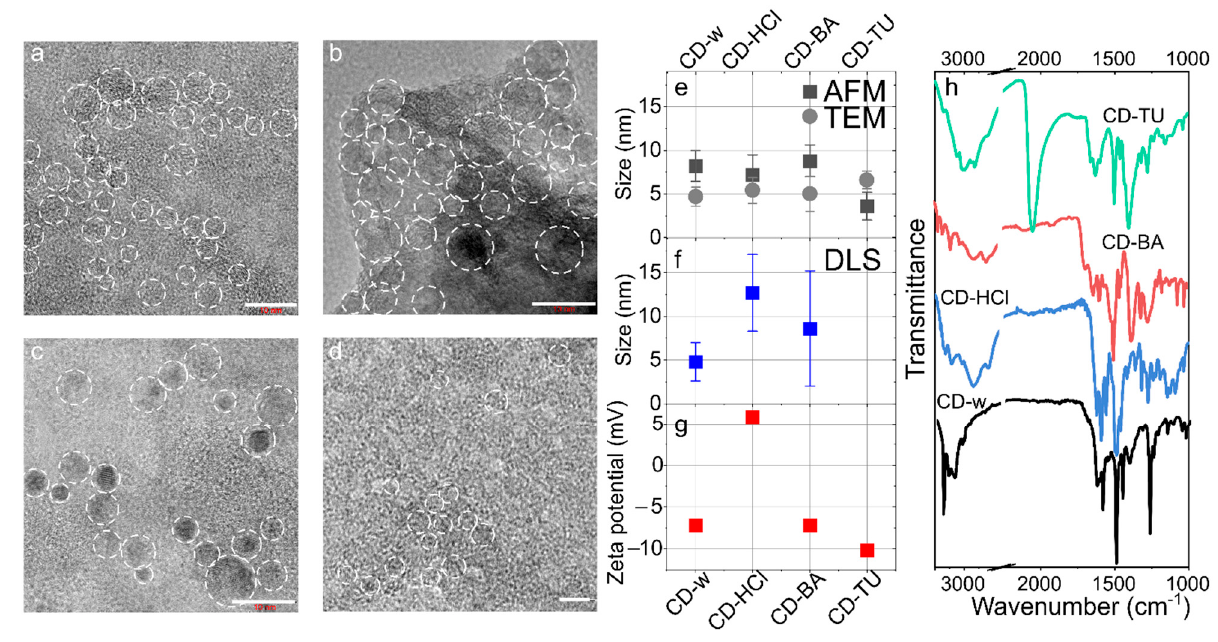
Figure 1. ( a – d ) Transmission electron microscopy (TEM) images of CDs: CD-w ( a ), CD-HCl ( b ), CD-BA ( c ), CD-TU ( d ). CDs are highlighted by dashed circles. The size bar is 10 nm. CDs sizes estimated from AFM (black squares) and TEM (grey circles) images ( e ) and DLS measurements ( f ). ( g ) ζ -potential of CDs. ( h ) FTIR spectra of CDs: CD-w (black), CD-HCl (blue), CD-BA (red), CD-TU (green).